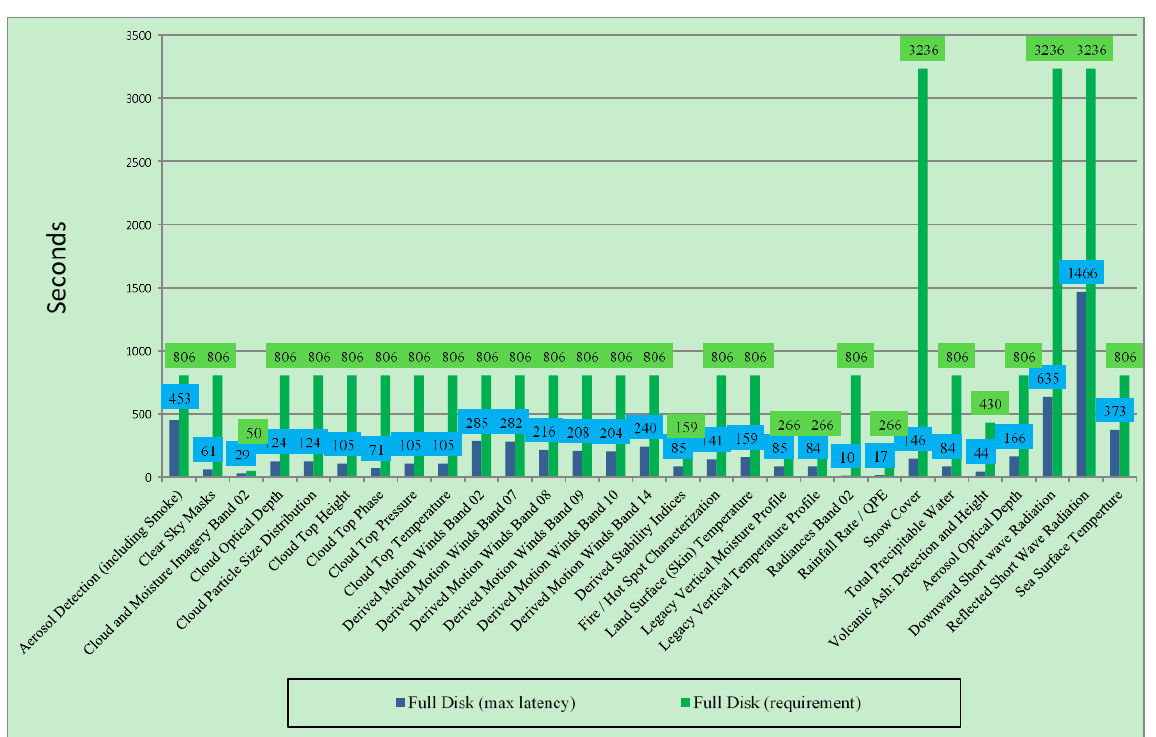
Figure 5. Cloud top pressure (mbar) generated by the GS using simulated ABI data.